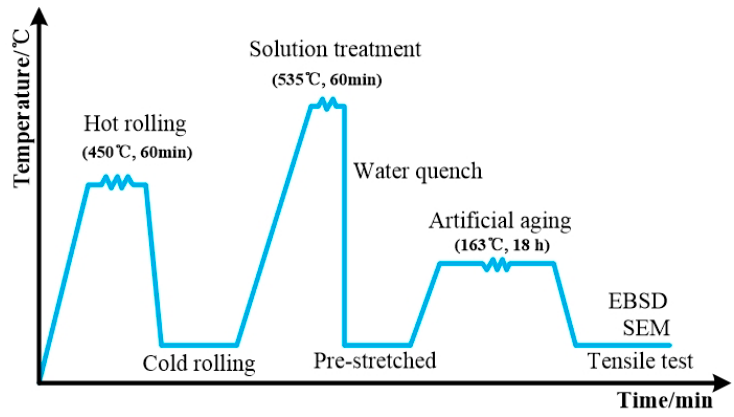
Figure 1. Schematic diagram of sample preparation and testing procedure.